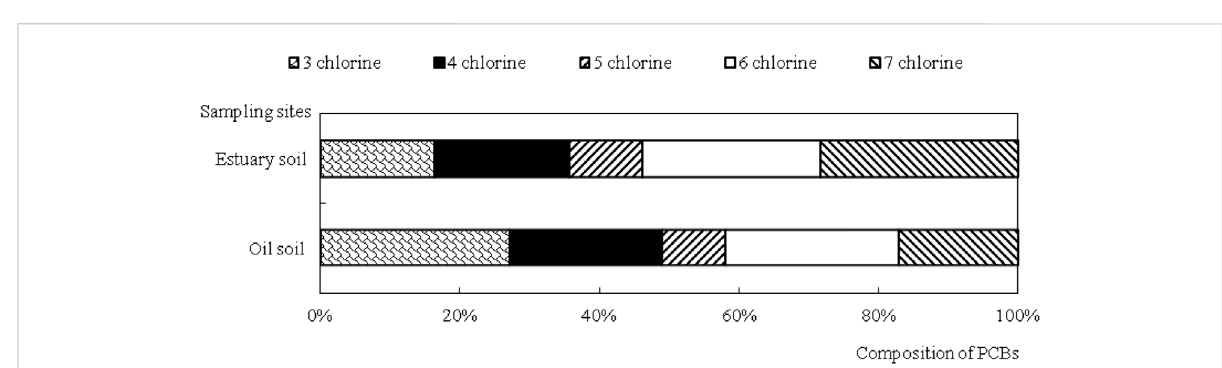
FIGURE 4 Compositions of different chlorines in total PCBs in oil soil and estuarine soil